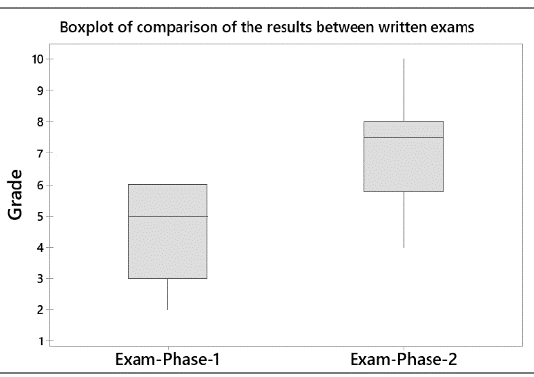
Table 4. Summary of the results of the usability